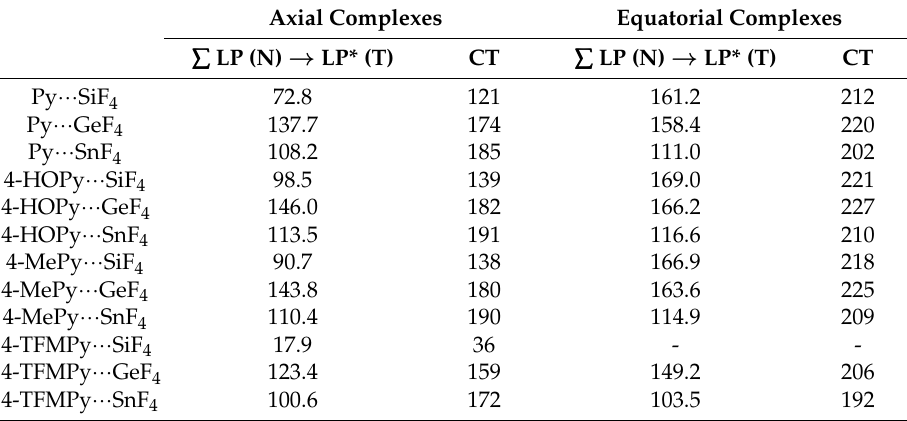
Table 9. NBO values of sum of E(2) (kcal/mol) for LP (N) → LP* (T), and total charge transfer (CT, me) from LB to TF 4 obtained at the BLYP-D3/def2-TVZPP level. Axial